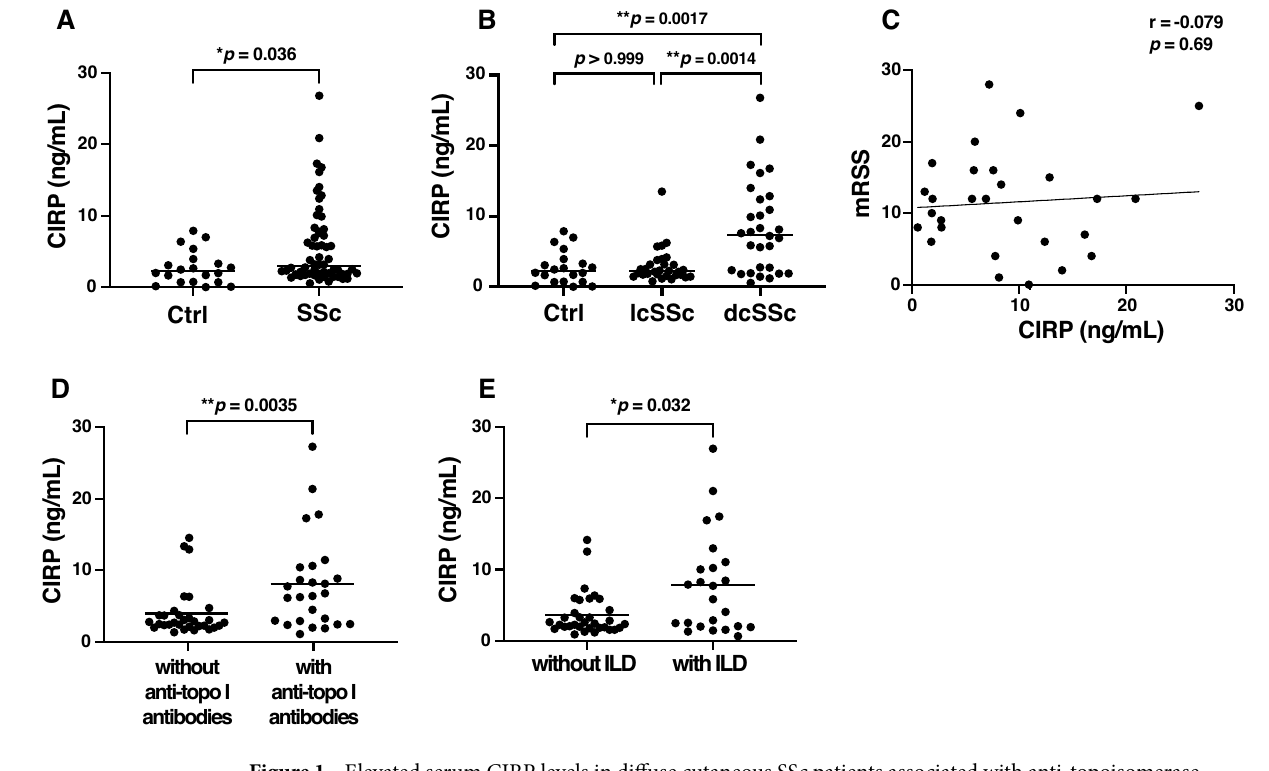
Figure 1. Elevated serum CIRP levels in diffuse cutaneous SSc patients associated with anti-topoisomerase I antibodies and interstitial lung disease. ( A ) Serum cold-inducible RNA-binding protein (CIRP) levels in systemic sclerosis (SSc; n = 60) and healthy controls (Ctrl; n = 20). Serum CIRP levels were determined by a specific enzyme-linked immunosorbent assay. ( B ) Serum CIRP levels in diffuse cutaneous SSc (dcSSc; n = 30), limited cutaneous SSc (lcSSc; n = 30), and healthy controls (Ctrl; n = 20). ( C ) Correlation analysis of serum CIRP levels and modified Rodnan total skin thickness score (mRSS) in SSc patients. The solid line represents the regression line. ( D ) Serum CIRP levels in SSc patients with anti-topoisomerase I (topo I) antibodies and those without anti-topo I antibodies. ( E ) Serum CIRP levels in SSc patients with interstitial lung disease (ILD) and those without ILD. * p < 0.05, ** p <